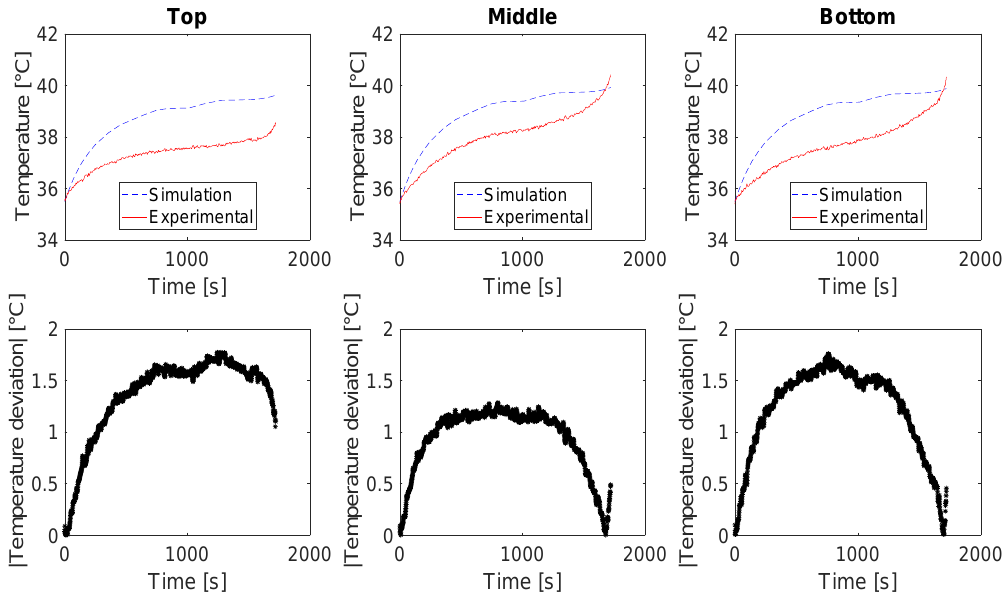
Figure 23. ( Upper ) Cycled cell surface temperature at three different locations (Top, Middle, Bottom) during high constant current discharge at 35 ◦ C cycling temperature; ( Lower ) Corresponding absolute value of the temperature deviation between experimental and simulations data.